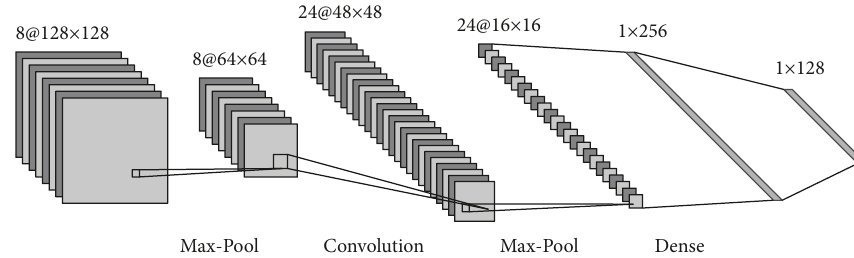
Figure 1: LeNet network model